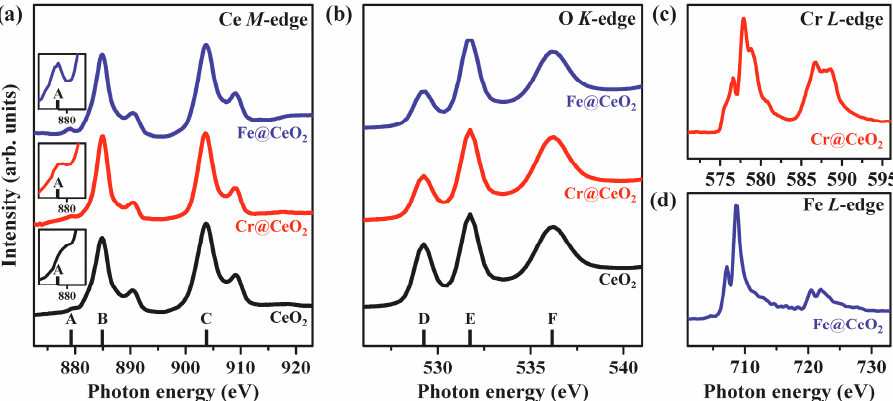
Figure 2. XAS profiles of ( a ) Ce M -edge, ( b ) O K -edge, ( c ) Cr L -edge, and ( d ) Fe L -edge for CeO 2